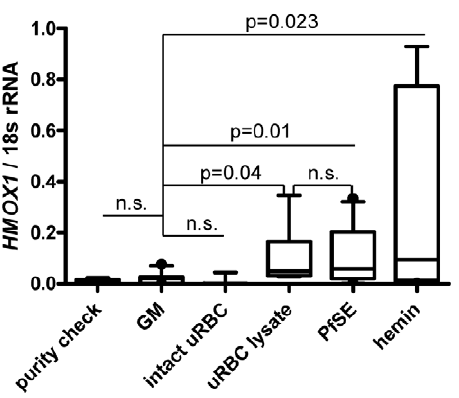
Figure 3. Hemin and lysed RBC can induce HMOX1 mRNA in neutrophils. Induction of HMOX1 mRNA in bead-isolated neutrophils is shown in response to 3 hours stimulation with growth medium (GM), intact uninfected RBC, a lysate of uninfected RBC, P. falciparum Schizont extract (PfSE), or hemin. Experiments were repeated independently 7 times. Wilcoxon matched pairs test was performed with p-values adjusted for multiple comparisons using Holm step down procedure. Box plots show medians and interquartile